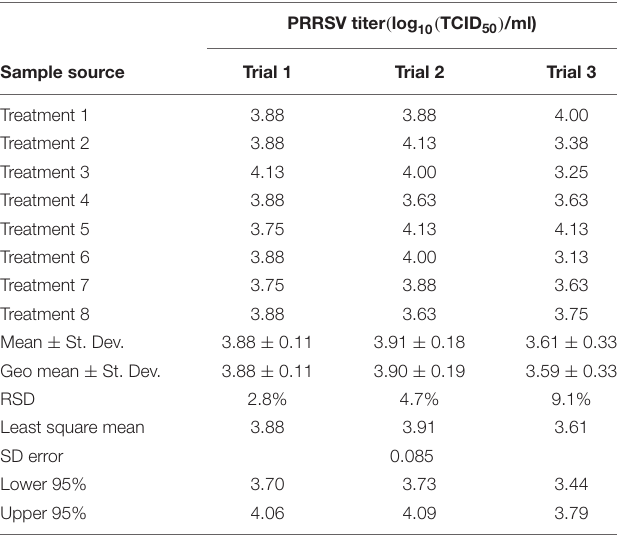
TABLE 7 | Experimental verification of uniformity of the PRRSV titer (log 10 ( TCID 50 ) /ml) in the sampling fluid among identical eight treatments. PRRSV titer ( log 10 ( TCID 50 ) /ml)